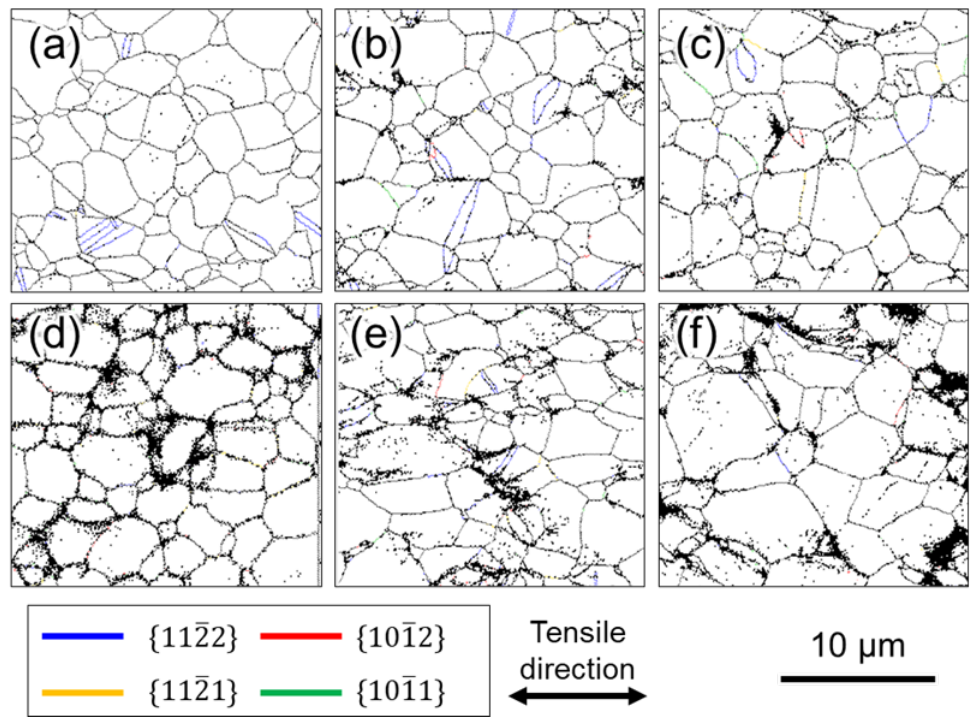
Figure 6. GB maps of Ti-5 after deformation. Interrupted specimens at ( a ) 7%, ( b ) 14%, and ( c ) 24% strain in high strain rates, and ( d ) 8%, ( e ) 14%, and ( f ) 24% strain in low strain rates.